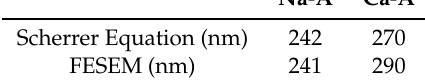
Table 3. Crystallite sizes (nm) calculated from FESEM data using Equation (3) compared to crystal size observed by FESEM. Statistical analysis shows a large spread of values from the Scherrer equation up to ± 28 nm; for FESEM data, the standard deviation is up to ± 14 nm.